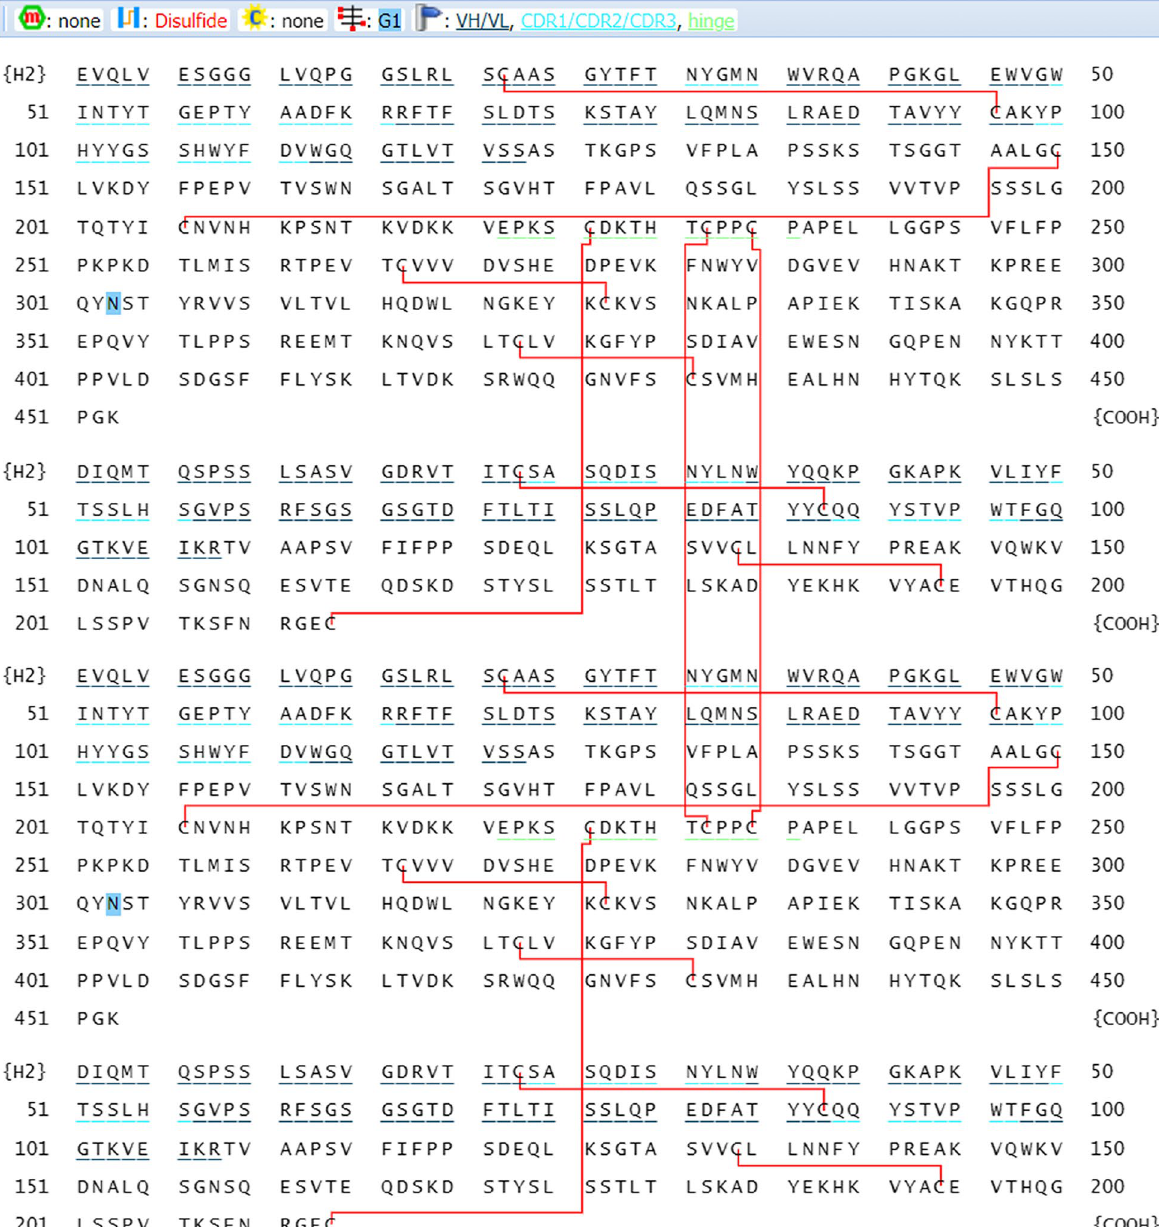
Fig. 6 BioMaps are dynamically rendered from a comprehensive sequence notation file for each molecule, in this case showing a monoclonal